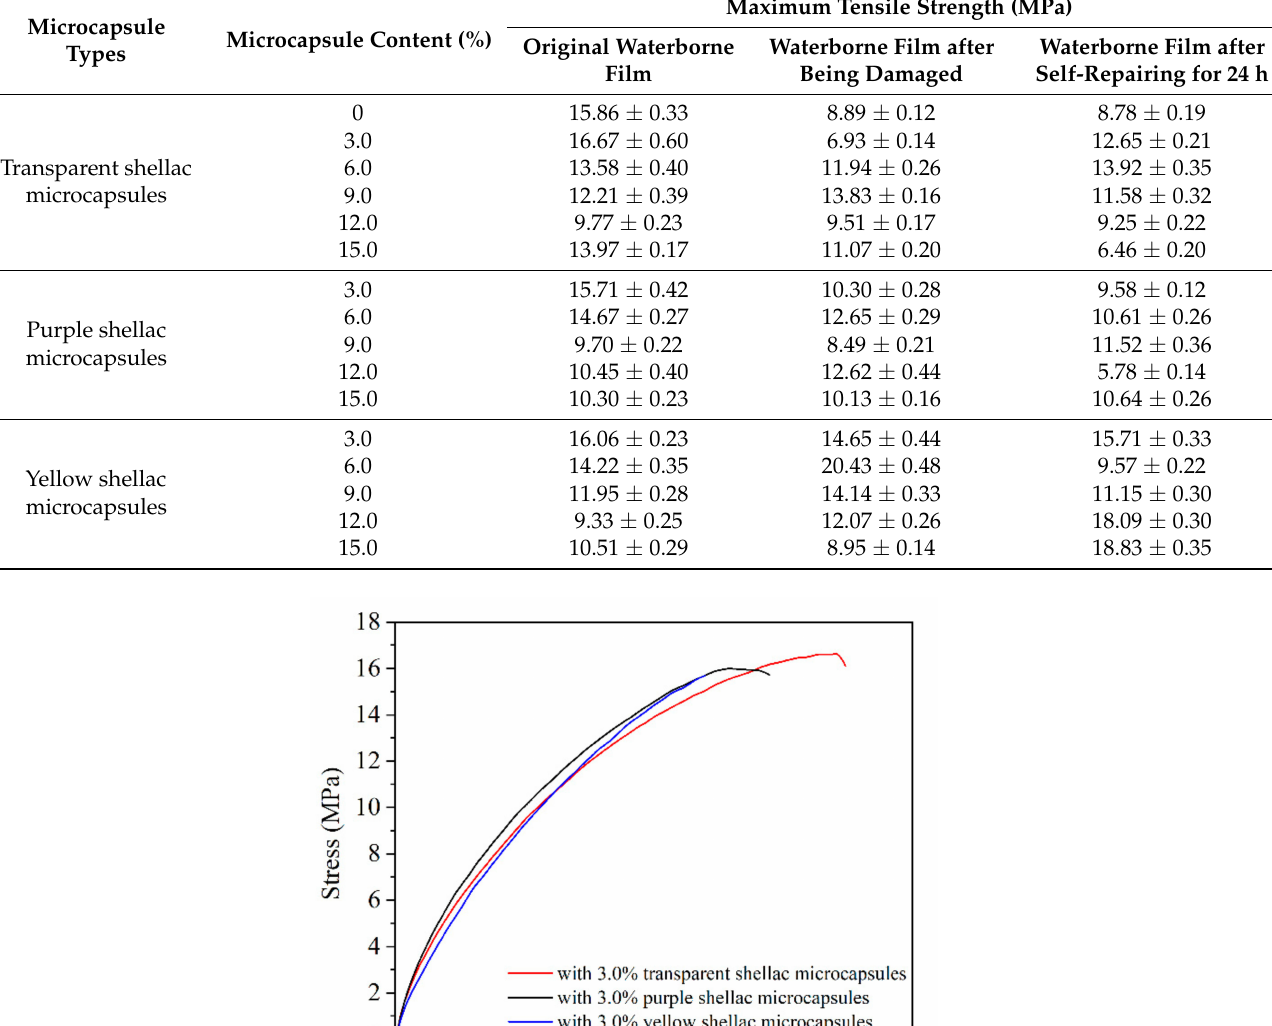
Table 4. Tensile properties of self-healing waterborne coatings with different microcapsules in three situations.